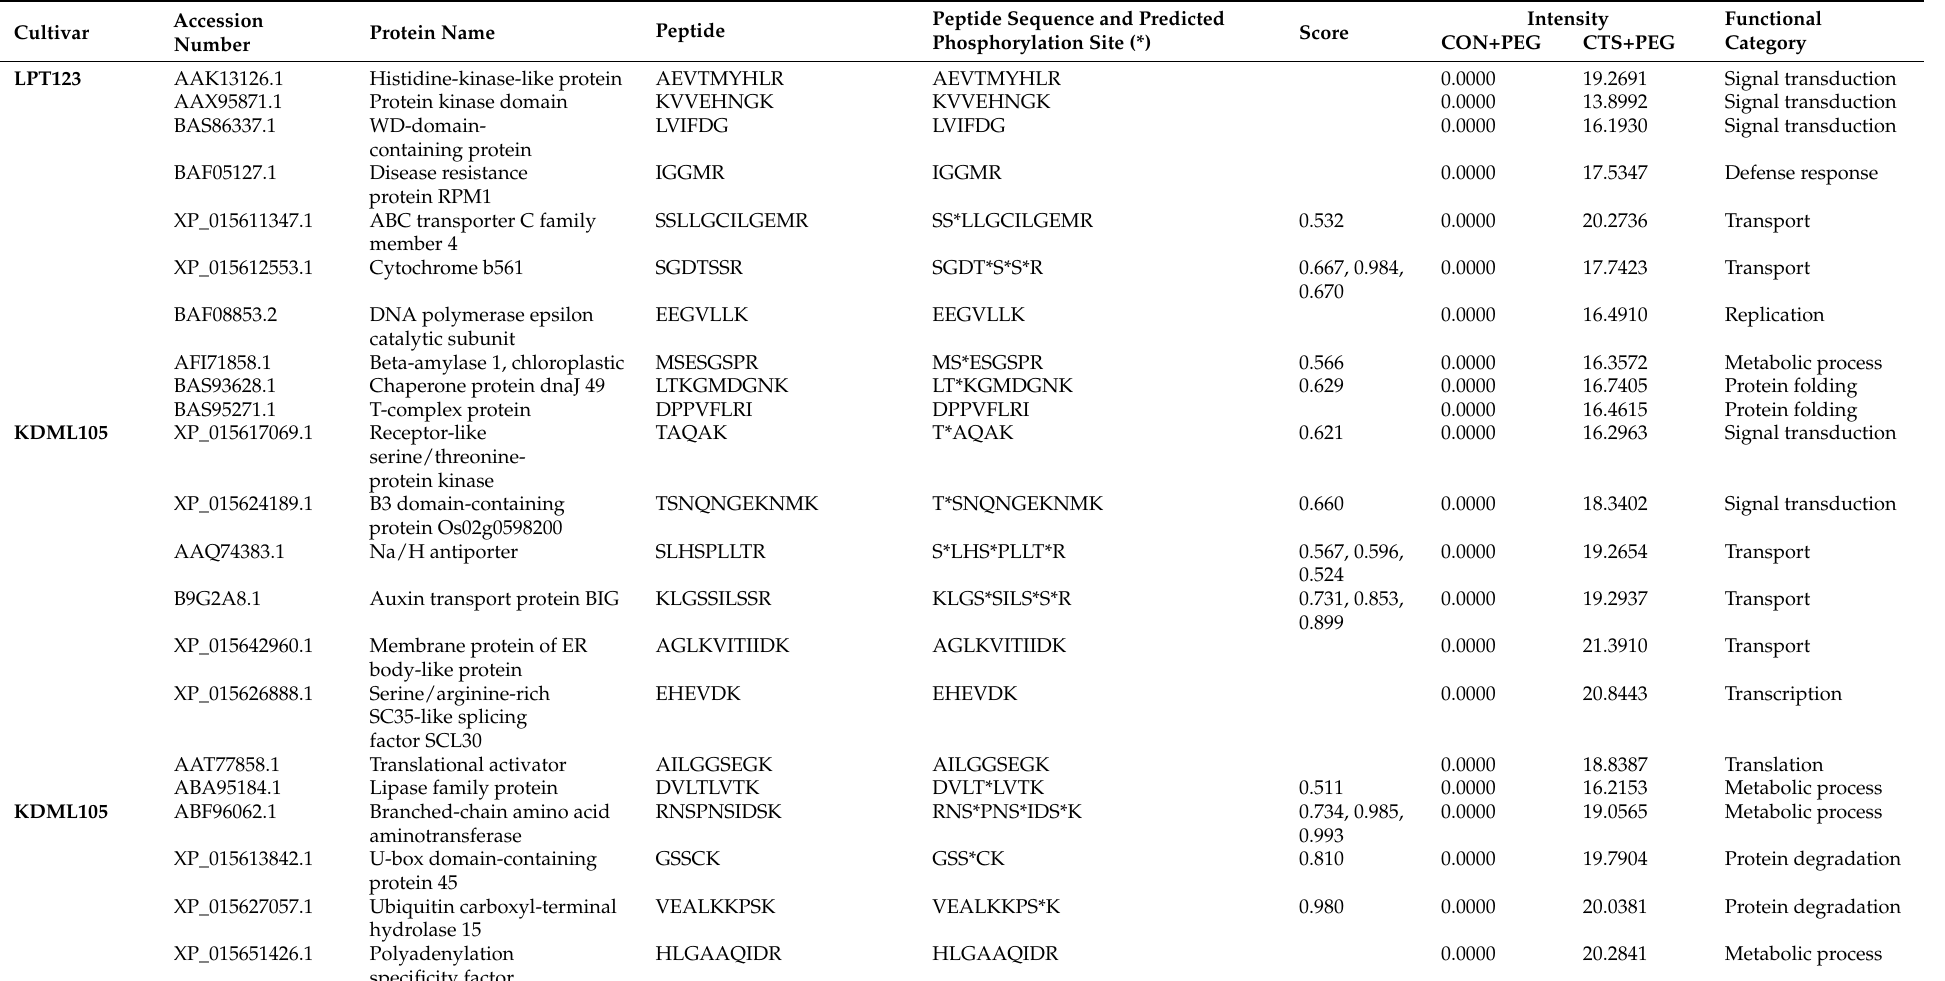
Table 2. The increased DEPs in both rice cultivars in response to CTS induction with osmotic stress